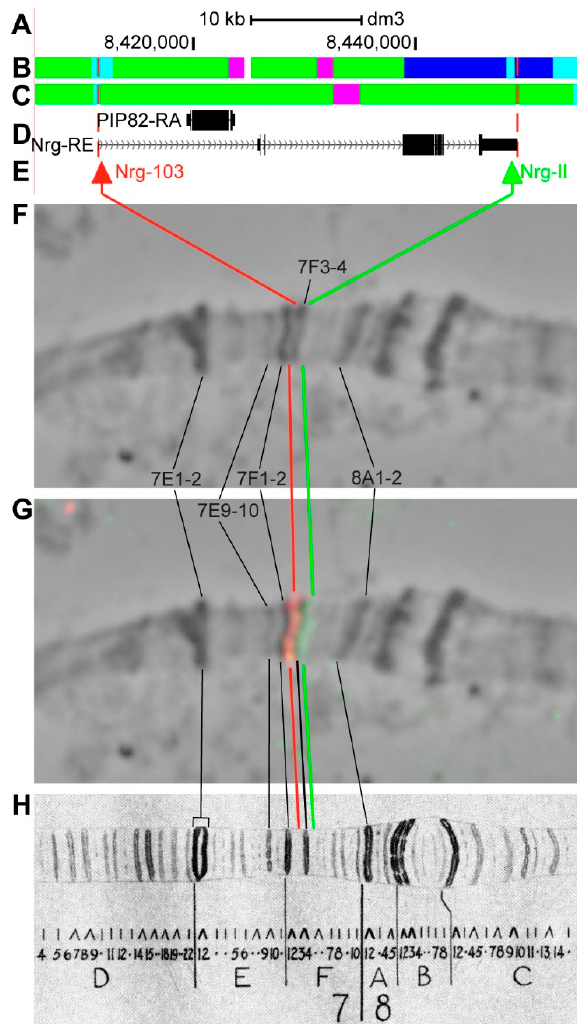
Figure 14. Localization of the Nrg gene in the 7F region (the gene is bound by red dotted lines). ( A ) the scale (kb) and genomic coordinates (bp); ( B ) the four chromatin-state model [39]; ( C ) the chromatin condensation level model [32]; ( D ) genes location (arrow lines show the gene orientation and black bars indicate the location of gene exons); ( E ) probes location; ( F ) phase-contrast micrograph of the region; ( G ) combined FISH signals; and, ( H ) C. Bridges’ chromosome map